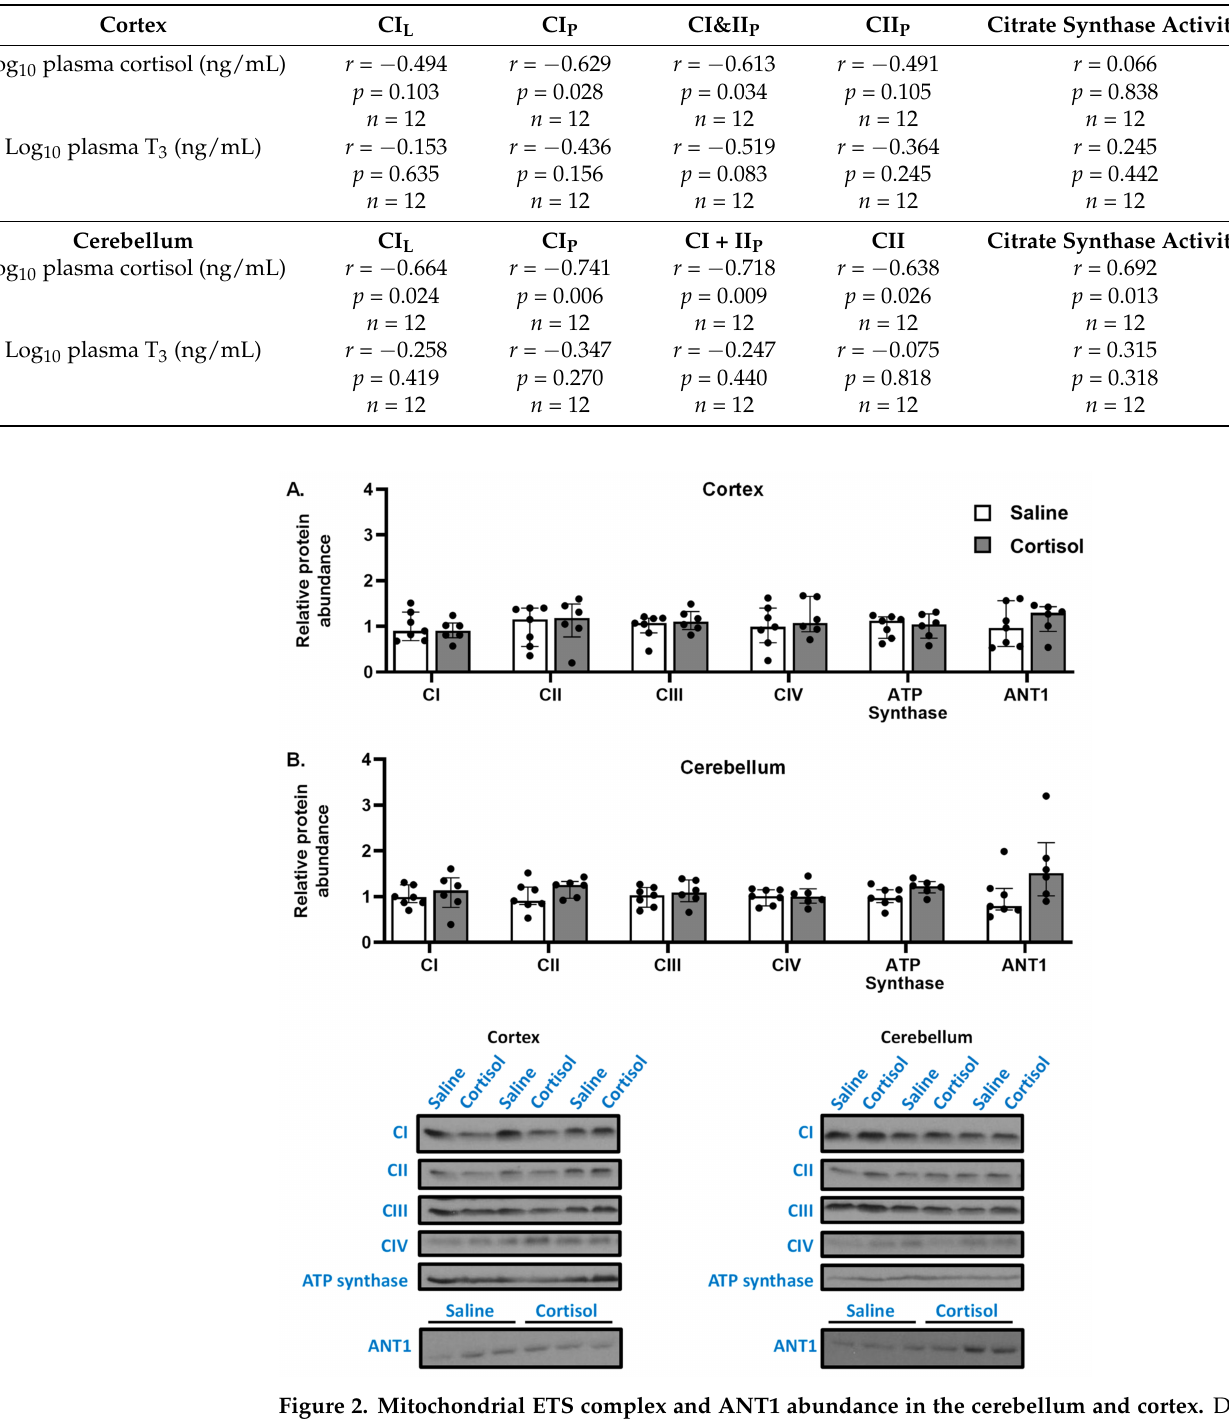
Figure 2. Mitochondrial ETS complex and ANT1 abundance in the cerebellum and cortex. Data presented as median and interquartile range with individual data points (black dots) for relative protein abundance in the cerebellum ( A ) and cortex ( B ) from saline (open columns, n = 7) and cortisol-infused (filled columns, n = 6) fetuses at ~130 days of gestational age